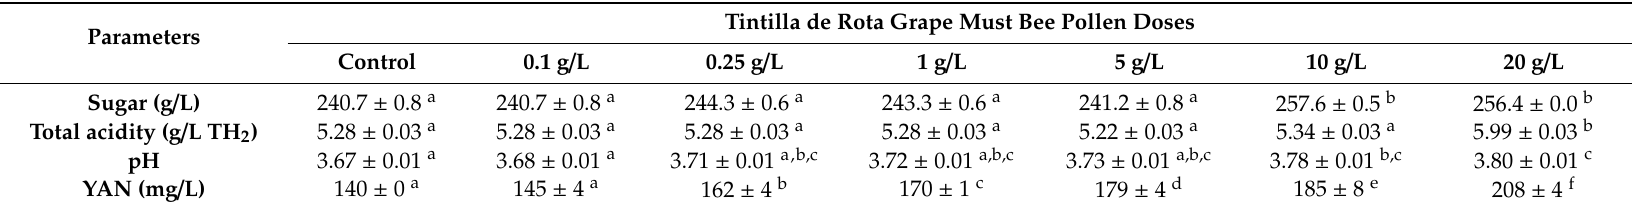
Table 1. Physicochemical composition of the must of Tintilla de Rota with the addition of pollen (control, 0.1, 0.25, 1, 5, 10, and 20 g / L).